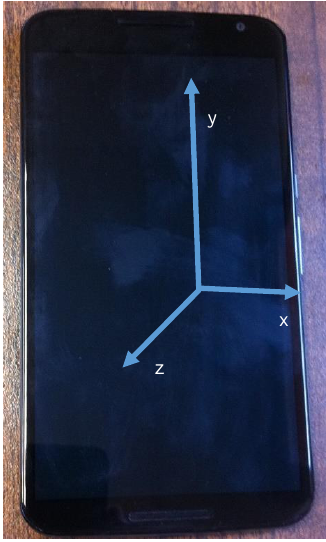
Figure 1. Nexus 6 mobile device and accelerometer axes.